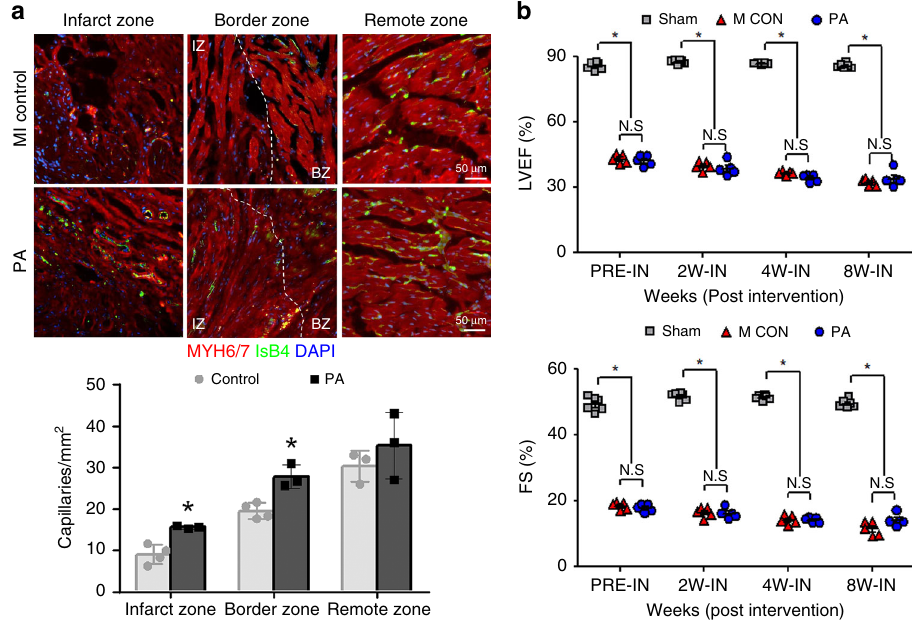
Fig. 2 hMSC-PA implantation only improved vascular regeneration. a hMSC-PA implanted to MI hearts were perfused with GFP-conjugated IsB4 to visualize the vessels, IsB4 (green). Representative images of capillaries on the infarct zone, border zone, and the remote zone at 8 weeks after MI and their quanti fi cation summary. For quanti fi cation, the number of capillaries on fi ve randomly selected fi elds in each heart was counted. The number of capillaries was counted per mm 2 within the infarct zone. Scale bars: 50 µ m. The data are represented as mean ± SEM. * p < 0.05 compared with control group; n = 5 biologically independent samples per group. T test was used for statistical analyses. b Rats undergoing MI were implanted with a hMSC-PA or control, followed by echocardiography analysis. Both ejection fraction (EF) and fractional shortening (FS) were not signi fi cantly higher than control group. The data are represented as mean ± SEM. * p < 0.05 compared with Sham group; n = 5 animals per group. One-way ANOVA was used for statistical analyses.